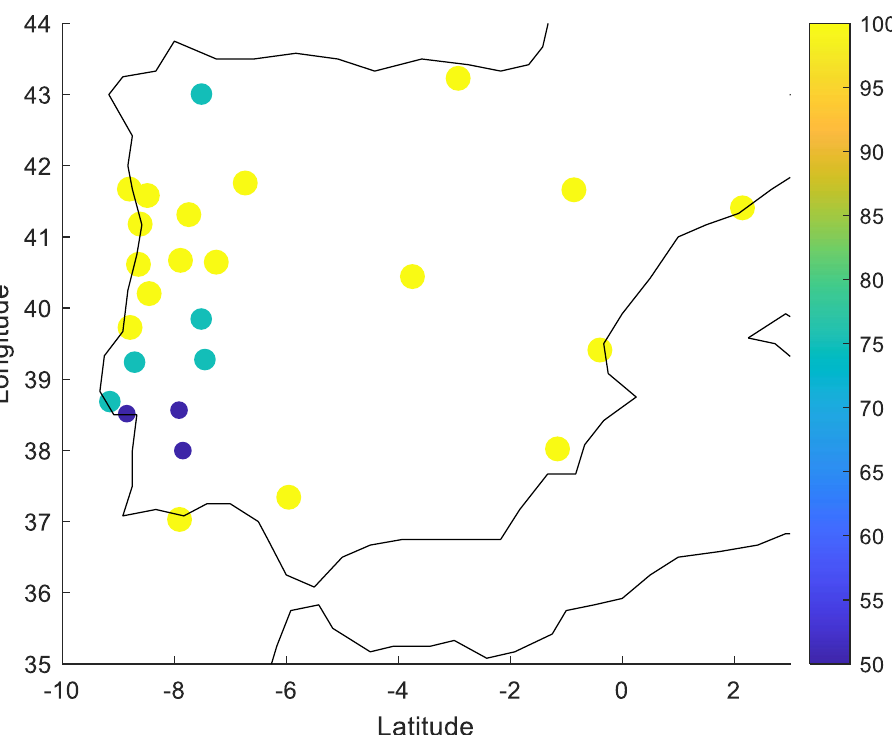
Figure 8. Average percentage of time for the July–October period that wind shear 0–6 km differences, future minus historic, are negative.